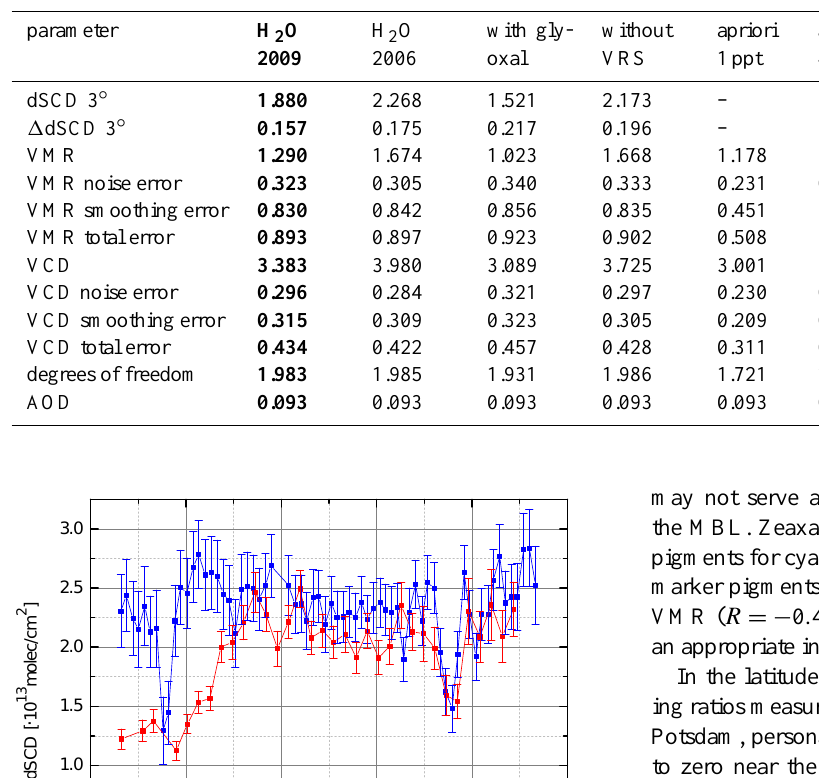
Table 4. Overview of retrieved quantities and their errors for different IO retrieval settings, averaged over all observations from 14 October 2009. The scenario in the first column (bold) corresponds to the optimal parameters found for the spectral retrieval. The basic parameters and settings are described in Sects. 3.3 and 3.4. The dSCDs are given in units of 10 13 moleccm − 2 , the VCDs in units of 10 12 moleccm − 2 and the VMR in ppt.